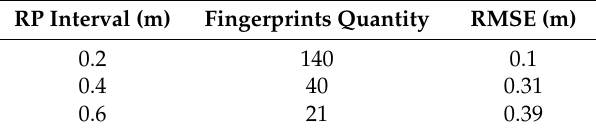
Figure 14. Localization accuracy under different fingerprint scale conditions. Figure 15. Effect of the adjacent thresholds on the localization accuracy.